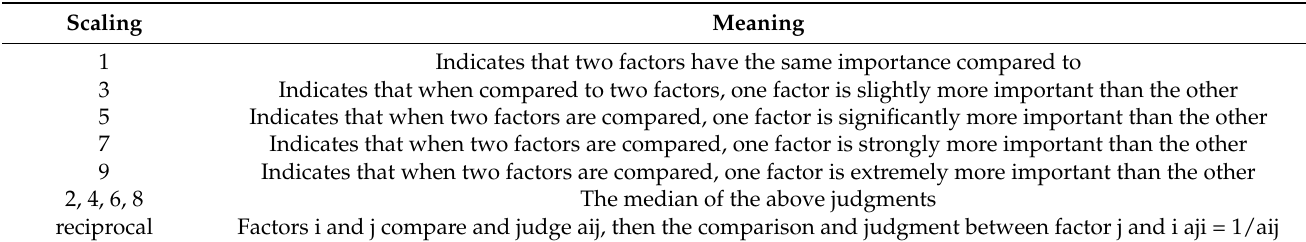
Table 1. Judgment matrix scale comparison table.